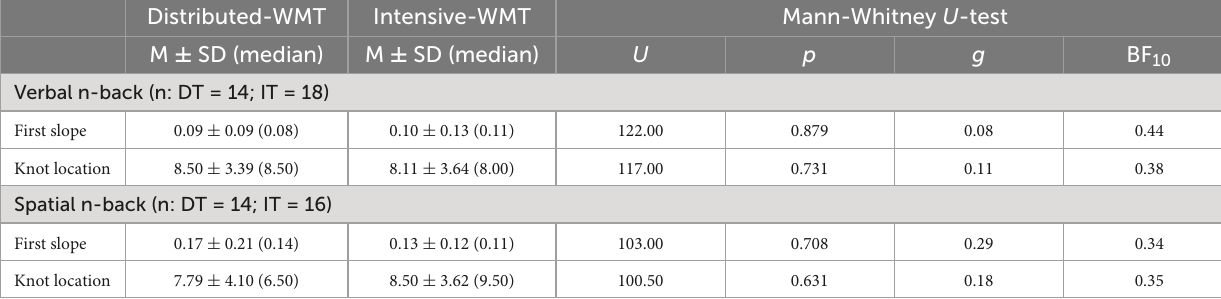
TABLE 3 Comparison of spline regression values.